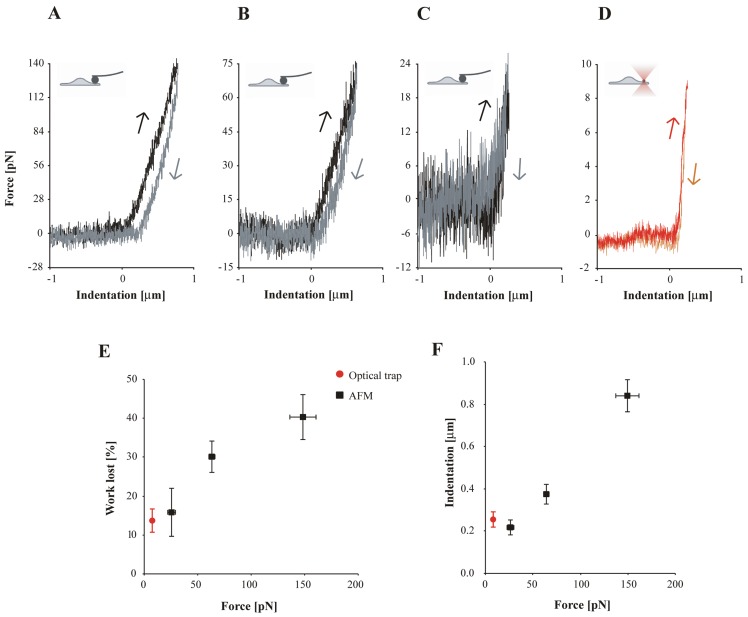
Sub-micron cell indentation with the optical trap and AFM.
A) Cell indentation measured with AFM. The force was limited to 140 pN. The indentation (black) and retraction (grey) curves are not identical, but show a considerable amount of hysteresis. B) When the indentation force is limited to 75 pN the difference between the curves is reduced. C) At a force of 25 pN, close to the intrinsic noise of the AFM cantilever, hysteresis between the indentation and retraction curves cannot be clearly distinguished. D) Cell indentation measured with the optical trap. The high force resolution allows the controlled application of forces of less than 10 pN. The indentation (red) and retraction (orange) curves look identical with no obvious hysteresis. E) The relative amount of energy lost between indentation and retraction curves (mean ± s.e.m) was obtained by numerically calculating the area that is enclosed by the indentation and retraction curve, and dividing this by the area under the indentation curve. Only those measurements were analyzed that showed no sticking of the bead to the cell (which is clearly visible as a negative force during retraction). Each point represents measurements on 7 to 15 different cells. Both optical trap (red) and AFM (black) measurements that were performed at forces of up to 30 pN show that less than 15% of the indentation energy is lost. At higher forces this increased to almost 50%. F) The cell indentation was estimated for all indentation curves that were used for E). Data is shown as mean ± s.e.m. Measurements performed at the lowest forces (<30 pN) resulted at indentations of 0.2 µm, which increases to 0.8 µm at 150 pN. The contact point was defined as the position in the indentation curve where the force reaches a value below 0 pN (starting from the maximum force). The error in this method depends on the noise during the force measurement and will lead to an underestimation of the real indentation. Since the force noise in the AFM measurements is larger as compared to optical trapping also the error in the estimated indentation is larger.